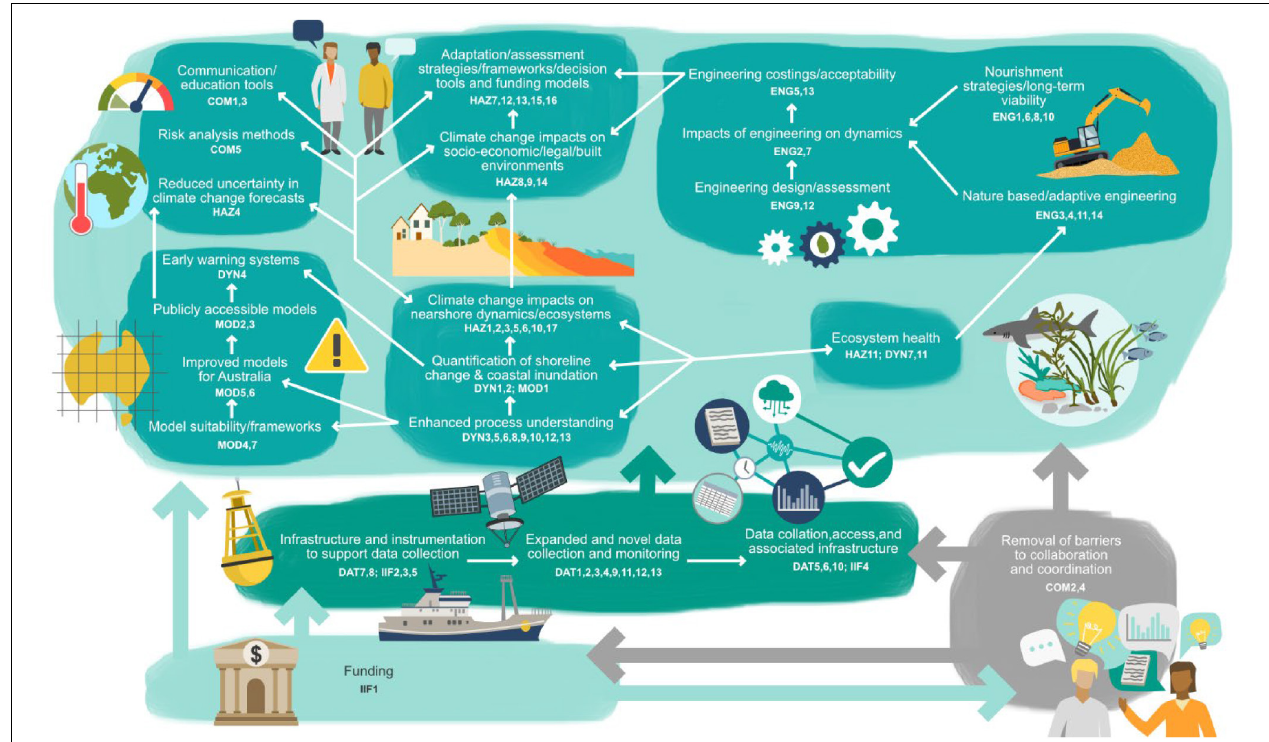
FIGURE 12 | A schematic diagram of the major linkages between the 74 priorities identified in this study noting that linkages and feedbacks can occur along multiple paths including paths not depicted here. See Table 1 for full priority